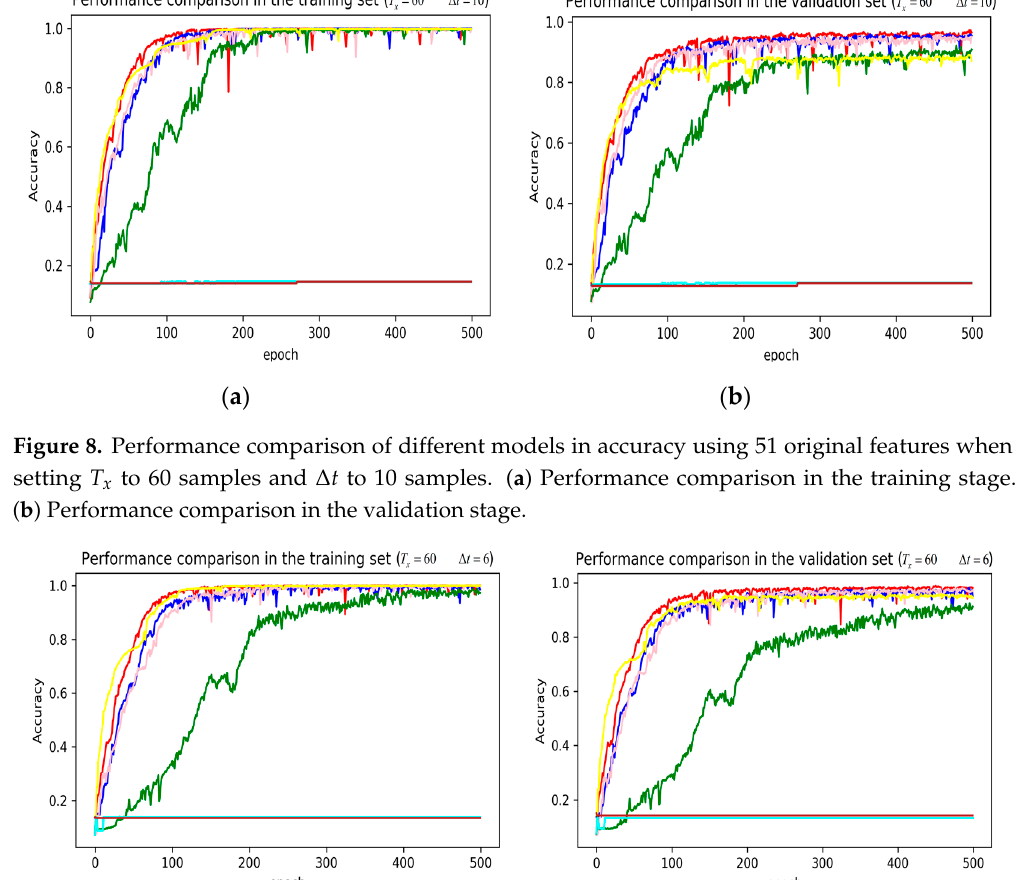
Figure 7. Performance comparison of different models in accuracy using 51 original features when setting T to 90 samples and t Δ to 45 samples. ( a ) Performance comparison in the training stage. ( b ) x Performance comparison in the validation stage.